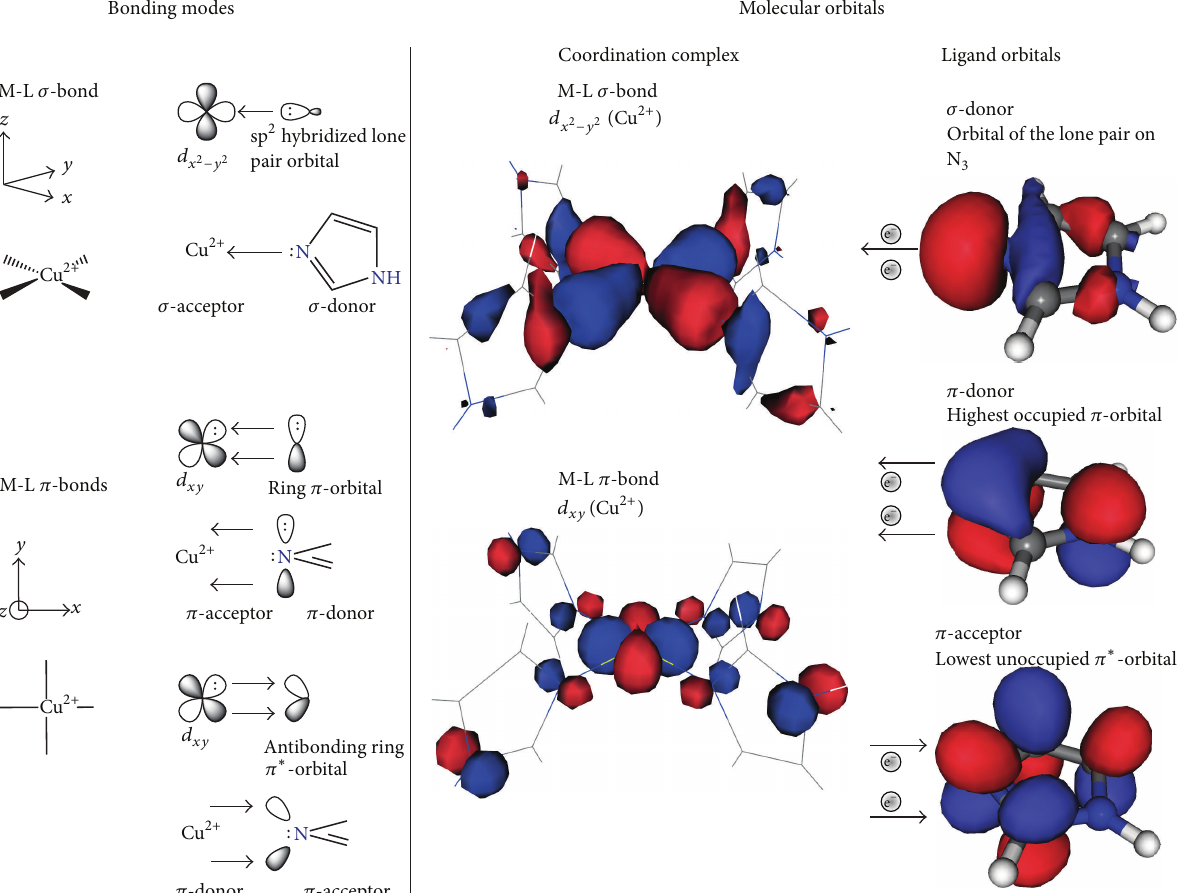
Scheme 5: Coordinate bonding modes (left) and molecular orbitals (right) envisaged for azole-Cu(II) in square planar geometry as obtained from DFT calculations [38]. The bonding principles are generic and applied also for Zn(II) and Cu(I) complexes.